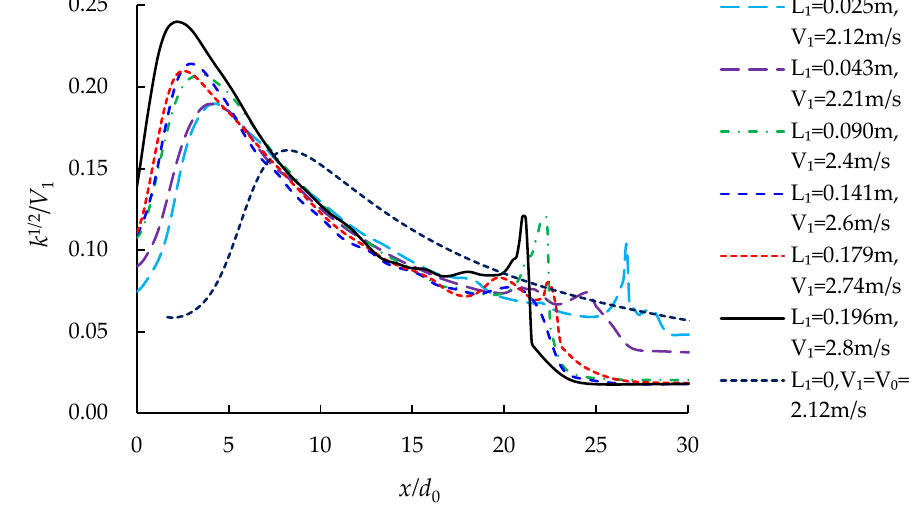
Figure 14. The TKE along the jet centerline with V 0 = 2 m/s for different L 1 .